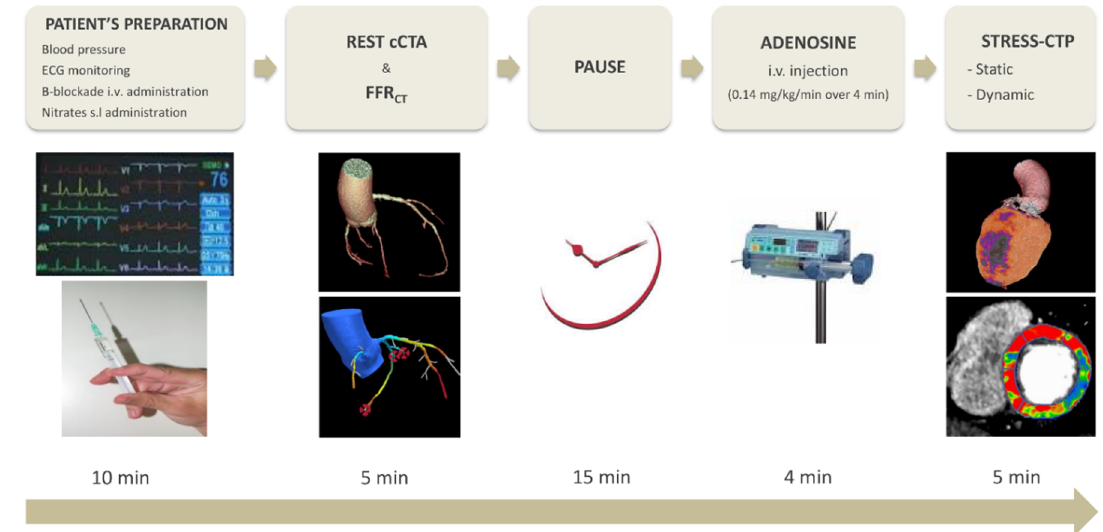
Figure A2. Study protocol. Patients were asked to refrain from smoking and caffeine for 24 h and to maintain fasting for 6 h before the scan. All patients were treated with sublingual nitrates to ensure vasodilatation. In patients with a resting HR > 65 beats/min, metoprolol was intravenously administered, with a titration dose up to 15 mg to achieve a target HR ≤ 65 beats/min. However, all patients were studied even if the target HR was not reached. cCTA and FFR CT were evaluated with the acquisition of the first dataset; then, after a period of fifteen minutes, perfusion evaluation was performed during adenosine administration with the acquisition of the second dataset (Static or Dynamic protocols were used according to the specific arm of the study). HR: heart rate; cCTA: coronary computed tomography angiography; FFR CT : computed tomography-derived fractional flow reserve.